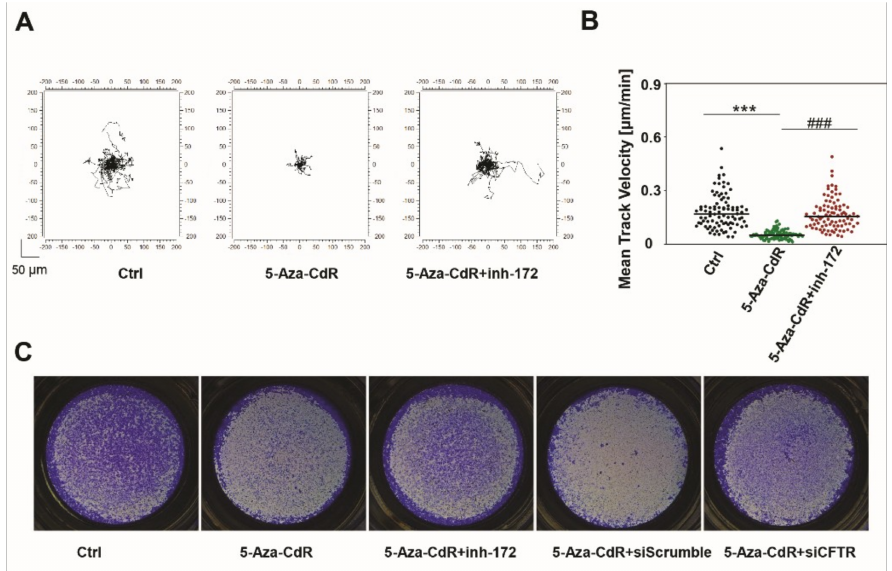
Figure 7. Epigenetic induction of CFTR regulates cell motility and invasion in A253 cells. ( A ) Representative 24 h time-lapse image from control (DMSO), 5-Aza-CdR-treated cells, and CFTR inh -172 and 5-Aza-CdR-treated cells showing 30 single cell motilities. A253 cells were aggressively motile, but 5-Aza-CdR treatment decreased this motility, and CFTR inhibition with CFTR inh -172 increased it. ( B ) Corresponding histograms quantifying motility parameters. Values are mean ± SD of the tracking of 90 cells (from three independent experiments; one-way ANOVA). ( C ) Matrigel invasion assay demonstrates that 5-Aza-CdR treatment largely mitigated invasion, and CFTR inhibition (CFTR inh -172, CFTR siRNA) increased the number of invading cells. Statistical significance was assessed using one-way ANOVA with Bonferroni’s test. Data are expressed as mean ± SD ( n = 3; *** or ### , p < 0.001). * indicates statistical significance compared with control; # indicates